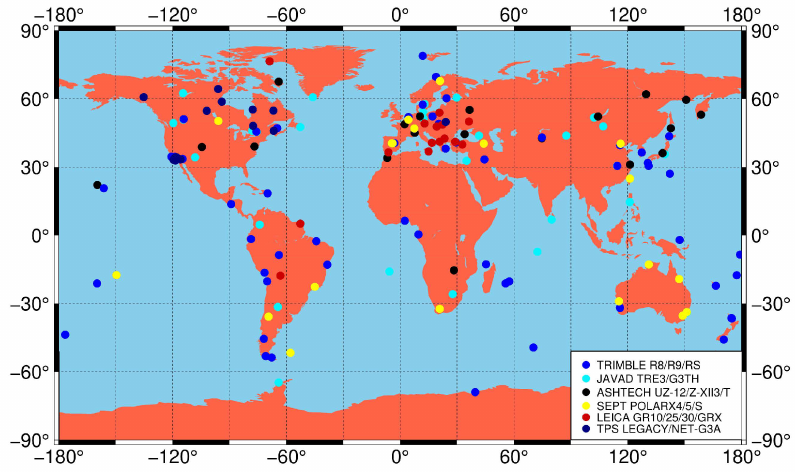
Figure 6. Geographic locations of receivers (of different types) that provide the second set of data analyzed in this